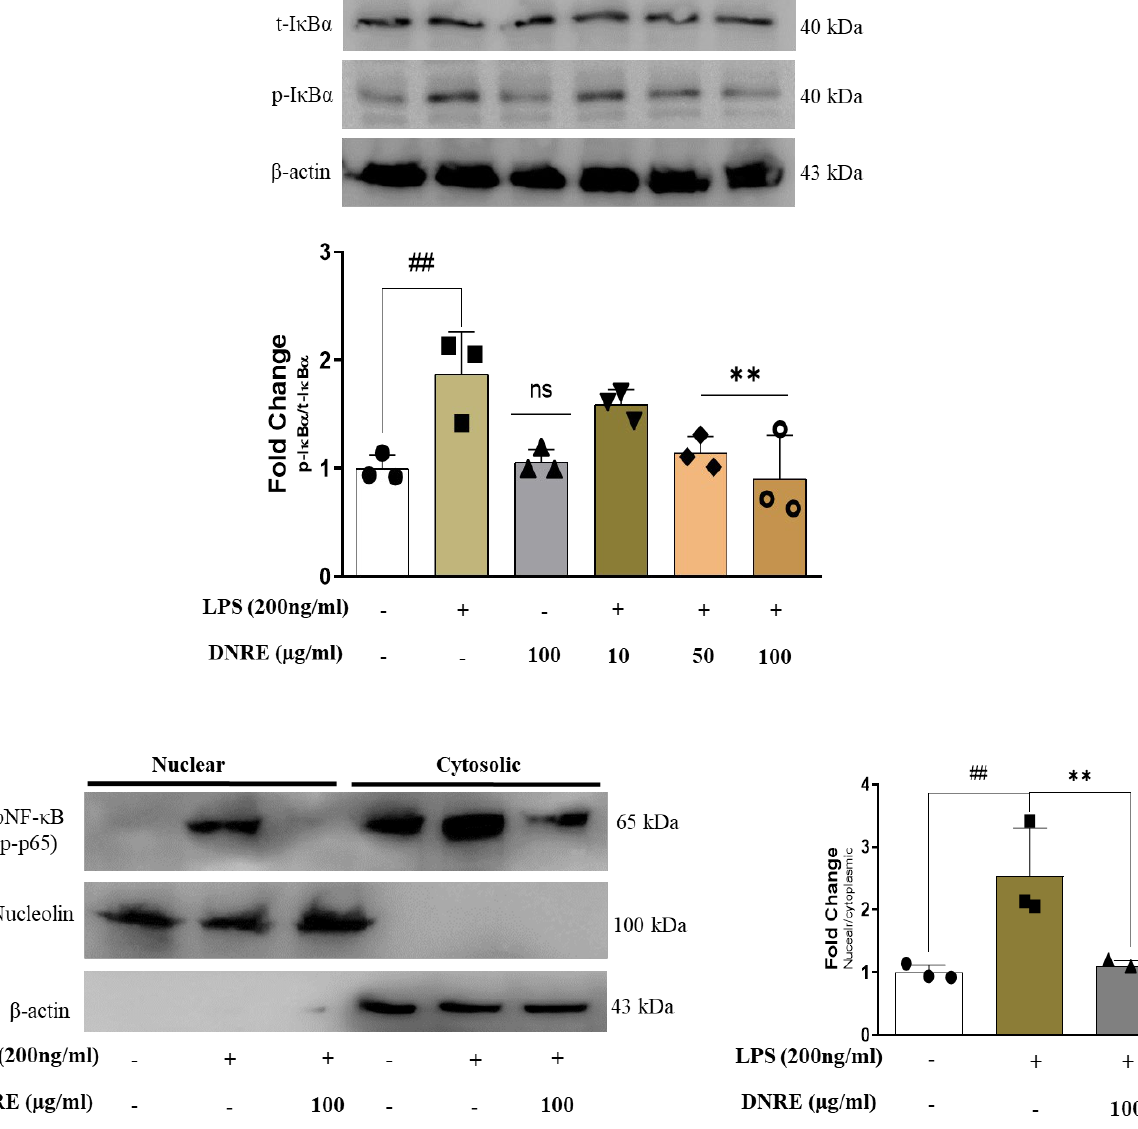
Figure 3. DNRE effects on nuclear factor. ( A ) Protein expression of I κ B and densitometric calculation. ( B ) Protein expression of phosphorylated NF- κ B (p-p65) of nuclear and cytoplasmic fractions of BV-2 cells treated with or without LPS (200 ng/mL). ns—not significant compared with non-treated; each shape (circles, triangles, squares, etc.) is representative of the number of repetitions of a particular group; ## p < 0.01, ### p < 0.001 compared with non-treated; ** p < 0.01, *** p < 0.001 comparing LPS vs. LPS + DNRE.